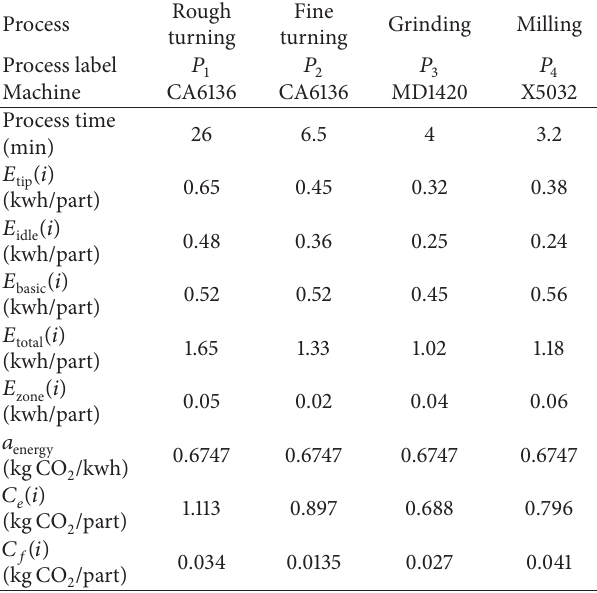
Table 2: Variables for the calculation of the energy-related carbon emissions.